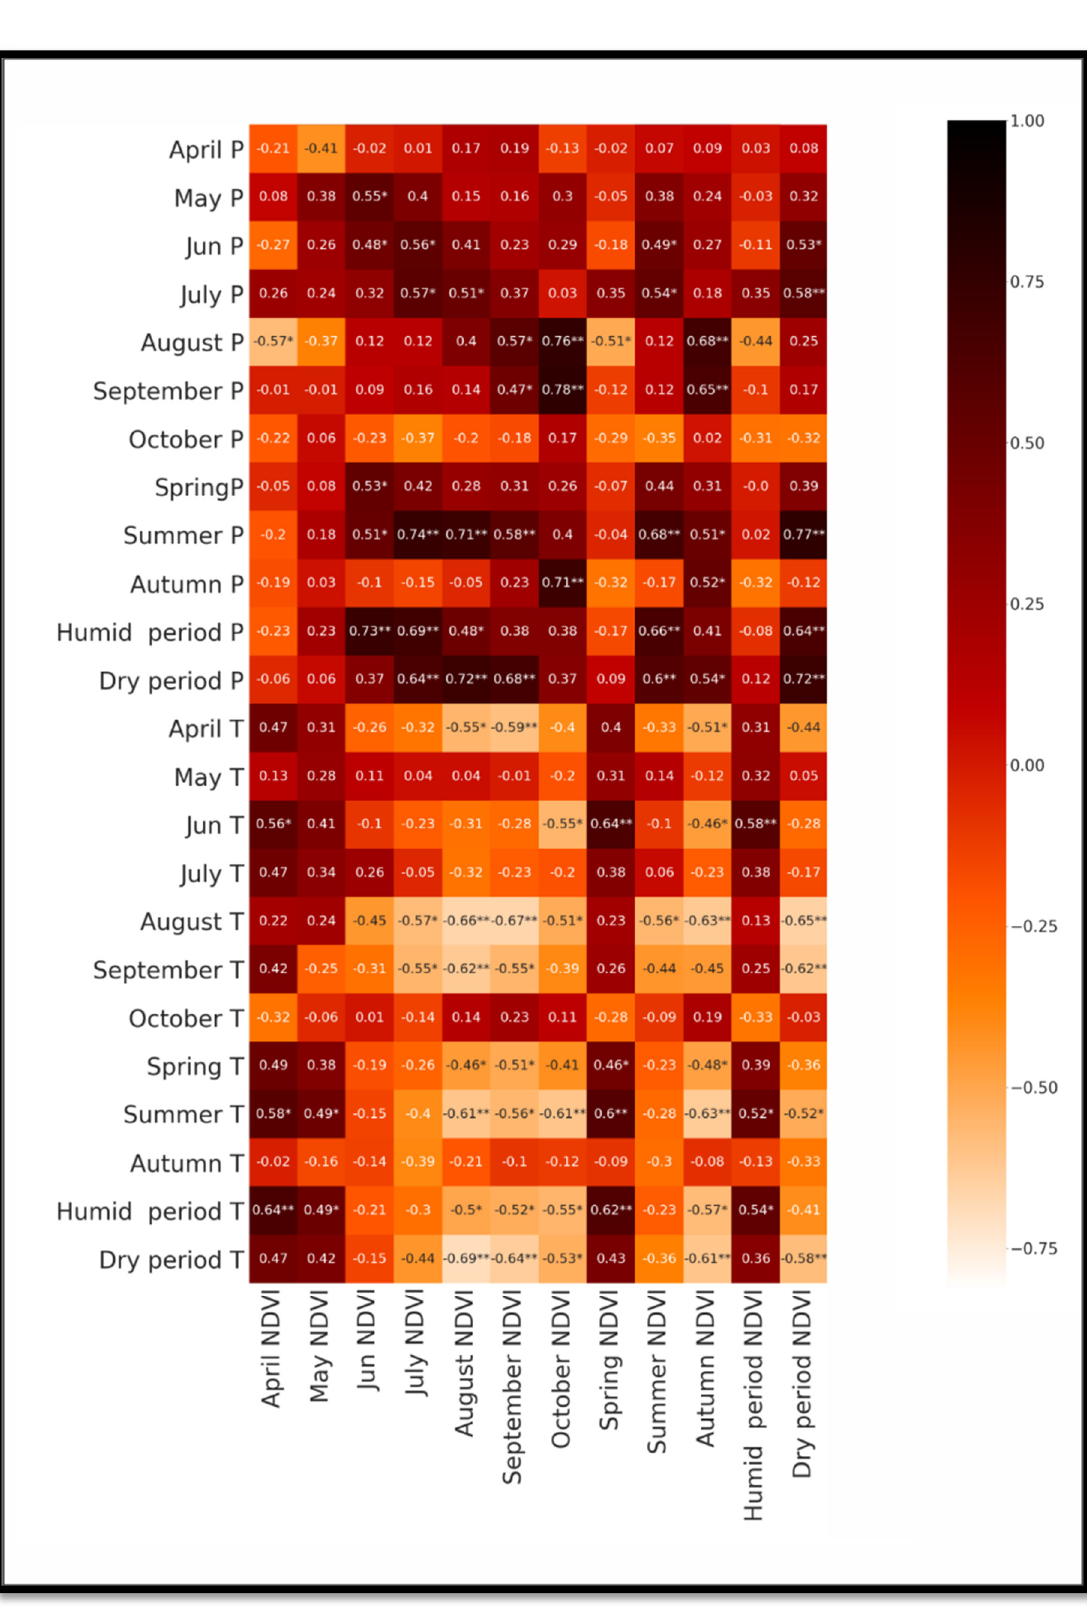
Figure 9. Correlation between temperature, precipitation, and the average monthly, seasonal LANDSAT NDVI data (with BRDF and topographic, atmospheric correction) for Sisian for the 2000–2018 period, with the levels of significance: *— p < 0.05, ** p <